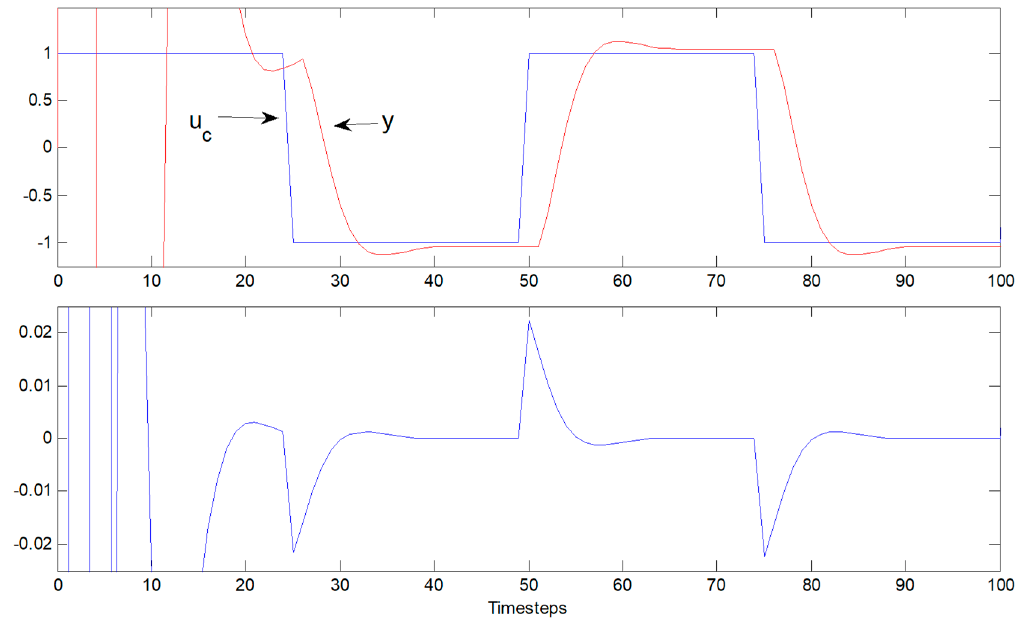
Figure 6 . Control u ( t ) output y ( t ) versus time for indirect self-tuner (no zero cancellation), non-minimum phase system.